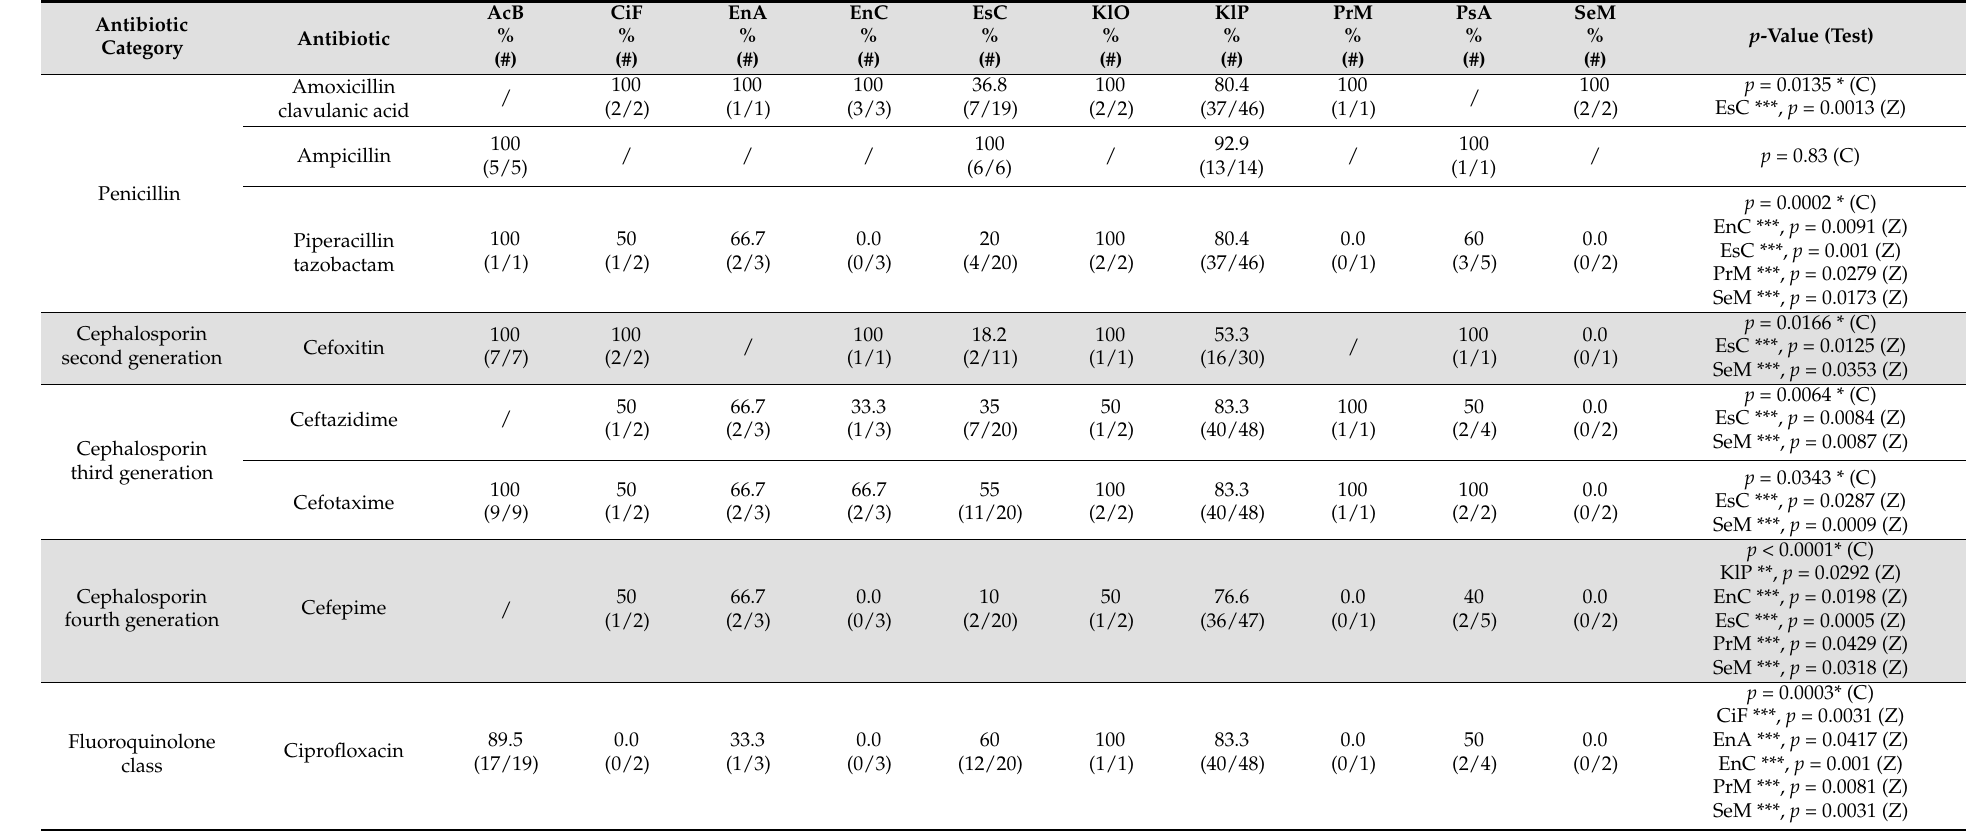
Table 4. Statistical analysis on the percentages of antibiotic resistance of 105 Gram-negative